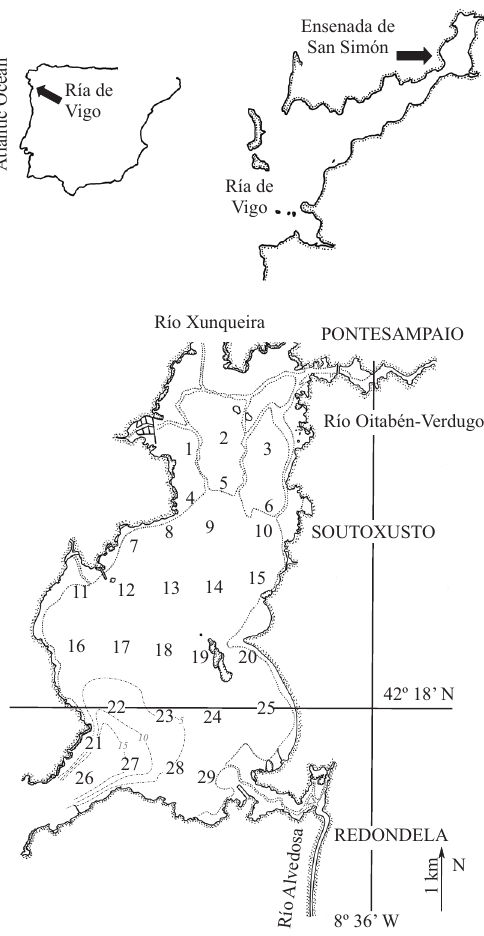
Fig . 1. – location of the Ensenada de san simón (ría de vigo) and position of the 29 sampling